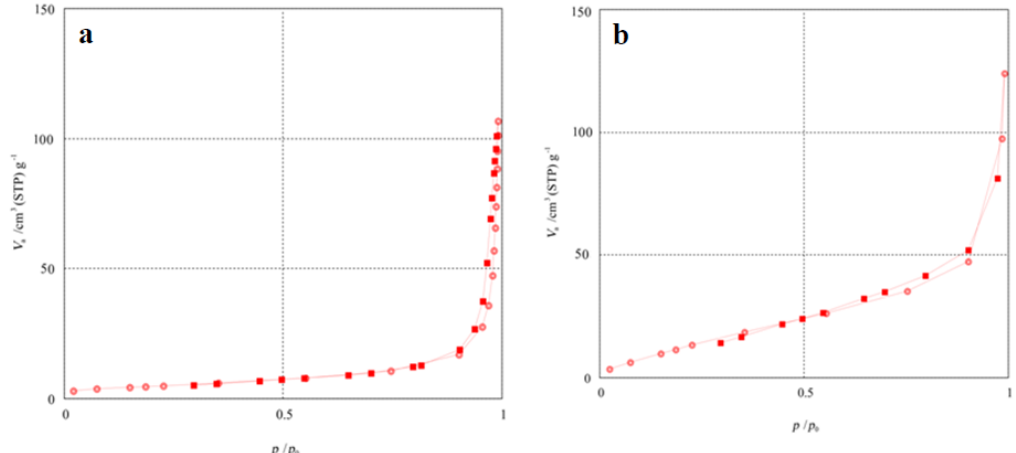
O /NiO, and (b) Co O /NiO@GQDs @SO 3 4 3 4